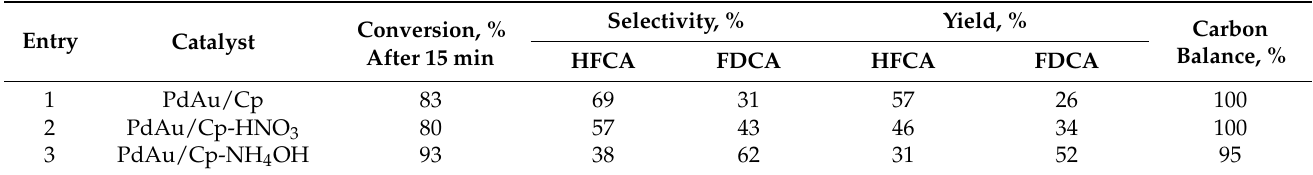
Table 2. Activity of Pd-Au/Sibunit catalysts with different treatment of support in HMF oxidation a . Entry